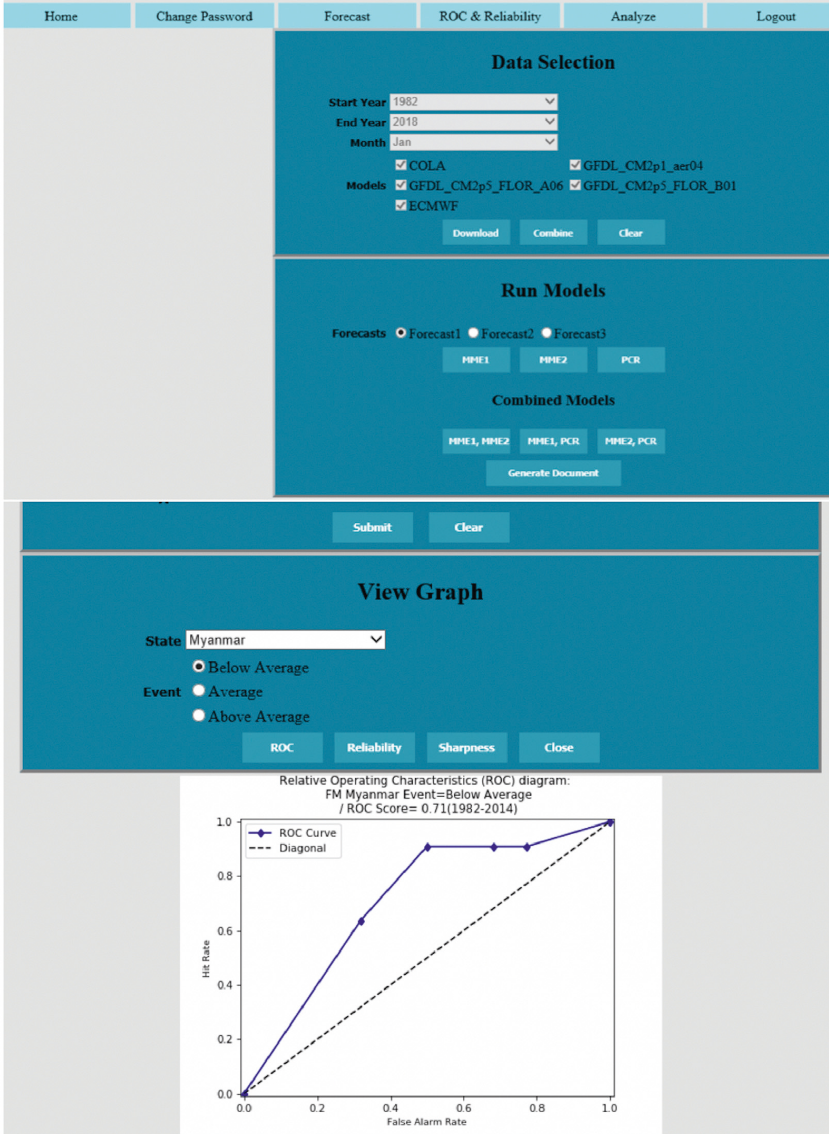
Figure 4: Screen capture of the Forecast Customization System (FOCUS) GUI developed using Python programming language (MME1 and MME2 refers to the AM-AMME and WA-MME schemes, respectively), showing the ROC score generation for the tercile